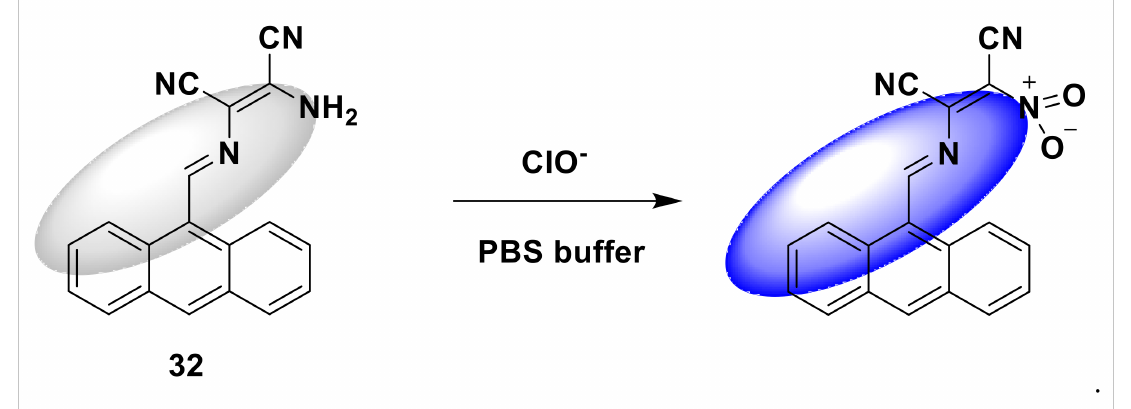
Figure 32. The reaction of probe 32 and CIO −